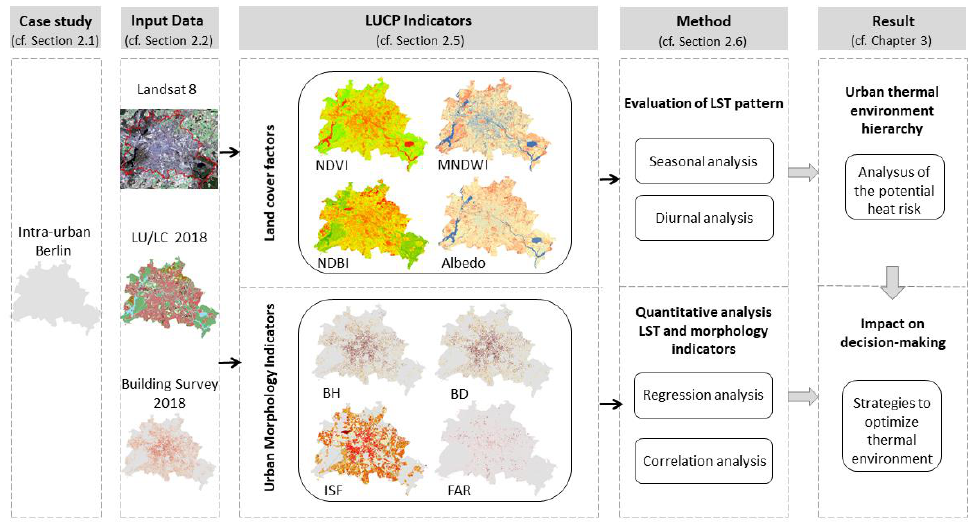
Figure 3. The conceptual framework to investigate statistical relationships between LUCP indices and LST characteristics.